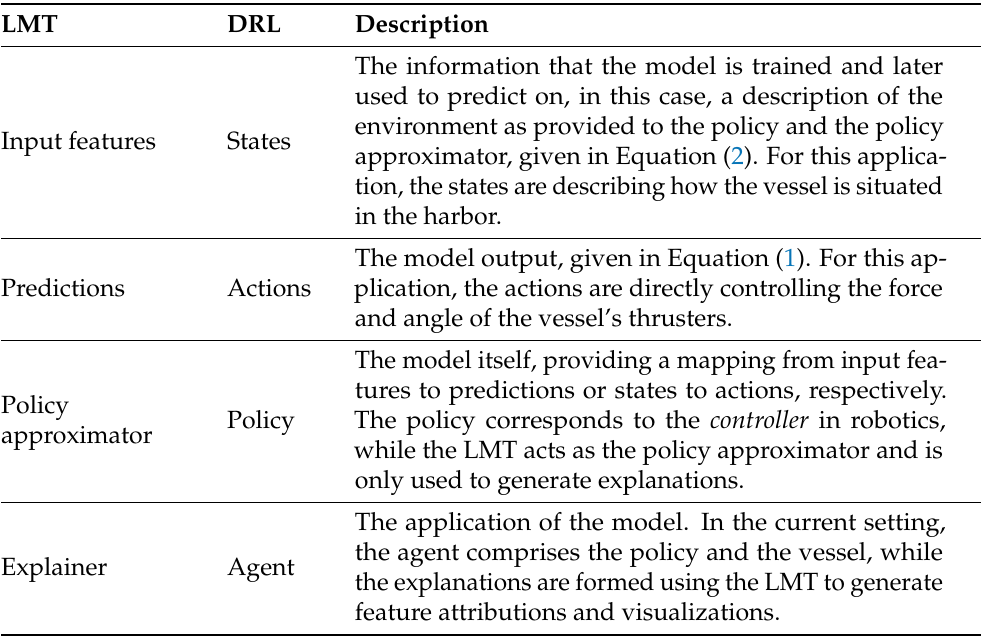
Table 2. Description of terms used in relation with the LMT and